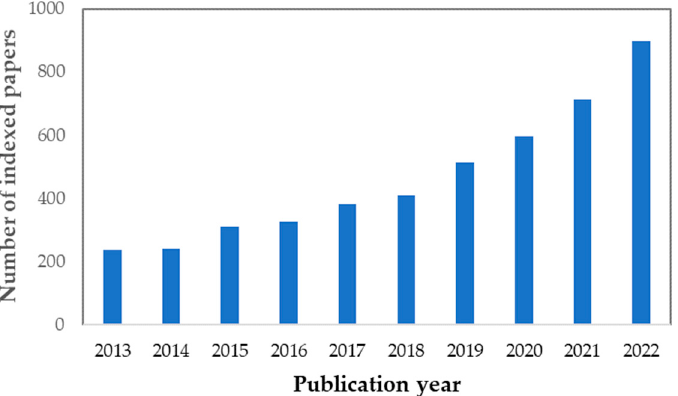
Figure 2. Trend of indexed papers on the topic published in the last ten years. Data taken from Scopus database (using keywords “azo dyes” AND “wastewater”).